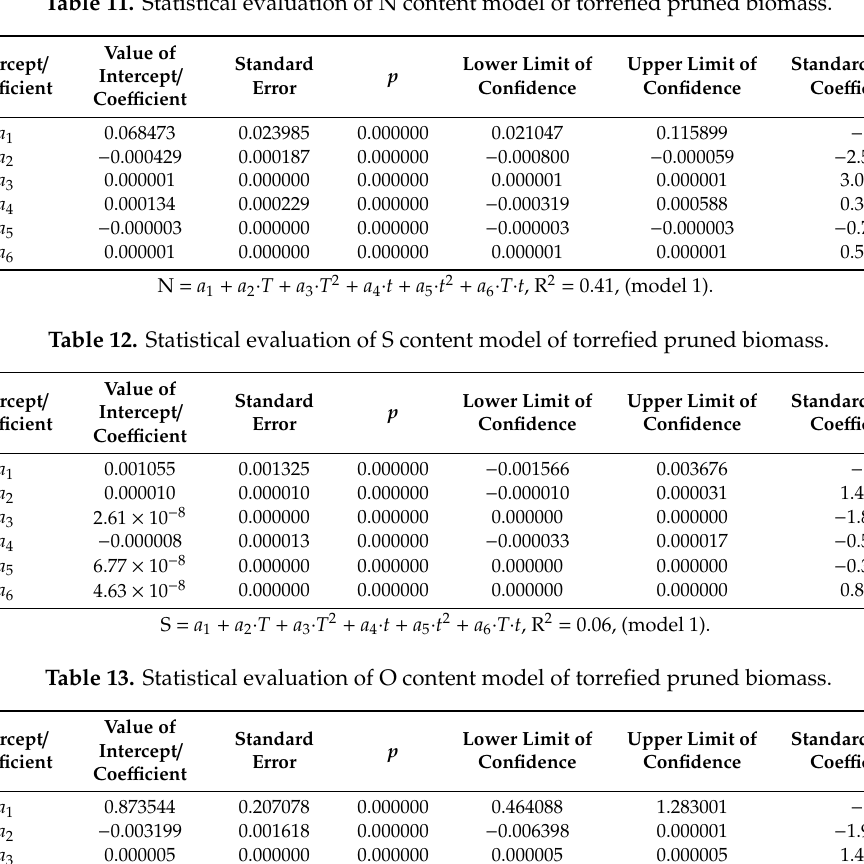
Table 11. Statistical evaluation of N content model of torrefied pruned biomass.